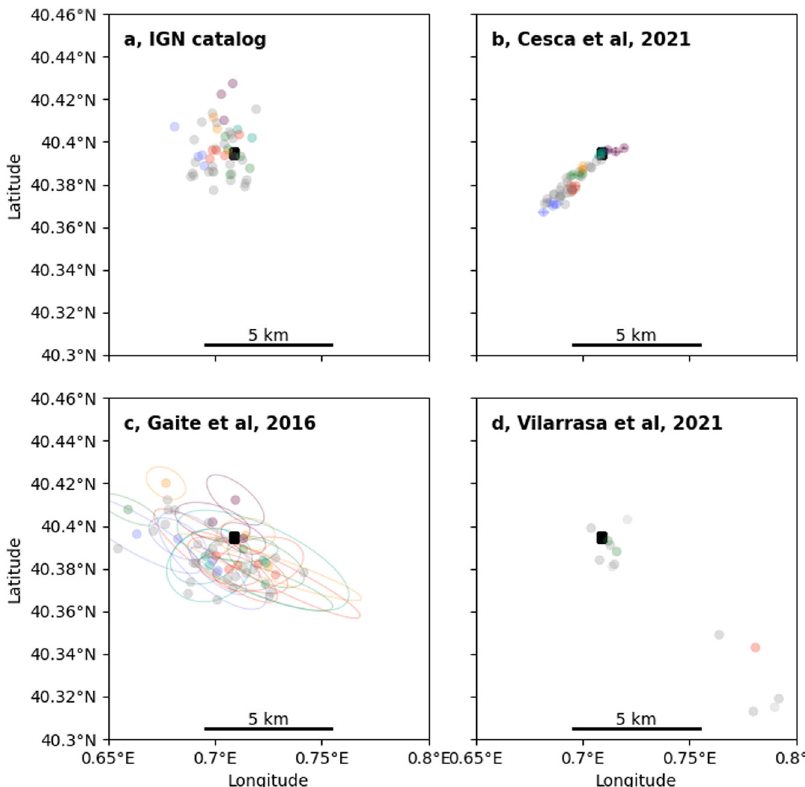
Fig. 1 Comparison of epicentral location maps. a Catalog of the National Geographic Institute of Spain (IGN), b relocation based on cross-correlations 2 , c absolute locations using a 3D model 5 , and d subset of 13 events 8 referred to such catalog 5 but with discrepant locations. Epicenters are plotted for a common dataset of 49 earthquakes with magnitudes larger than 2, out of the 51 for which a waveform-based classi fi cation was performed 2 , except in ( d ), where we only plot the 13 available events in such dataset. Colored epicenters correspond to different families of earthquakes with high waveform similarity, which should be tightly located. Uncertainties are reported for the clustered events in ( b ) (as latitude and longitude bars) and ( c ) (ellipses). A black square marks the location of the Castor